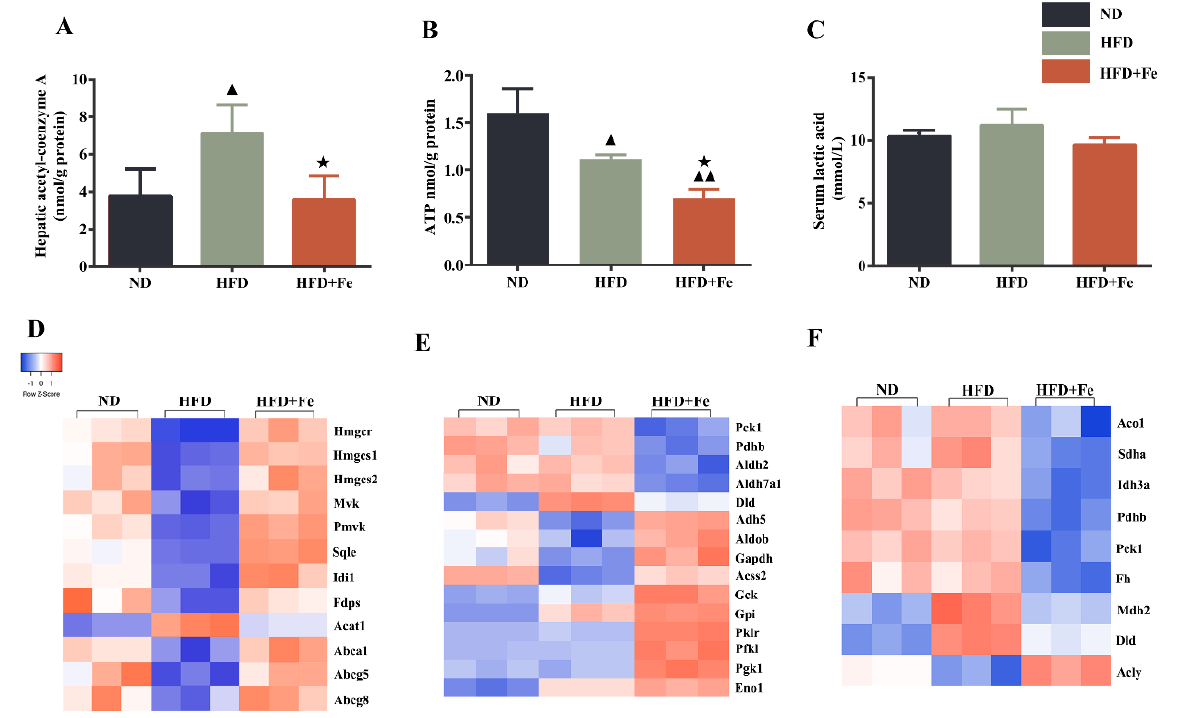
Figure 2. Dietary iron overload-induced metabolic changes in ApoE KO mice. ( A – C ) Hepatic acetyl-CoA and ATP levels and serum lactic acid content were determined at 16 weeks after diet intervention. Data were expressed as the mean ± SD. ▲ p < 0.05 vs. ND, ▲▲ p < 0.01 vs. ND, ★ p < 0.05 vs. HFD; n = 6. ( D – F ) Heatmap of differentially expressed hepatic proteins involved in cholesterol me ‐ tabolism ( D ), glycolysis ( E ), and tricarboxylic acid (TCA) cycle ( F ). ND: normal diet; HFD: high ‐ fat diet, HFD + Fe: HFD supplemented with 2% carbonyl iron.